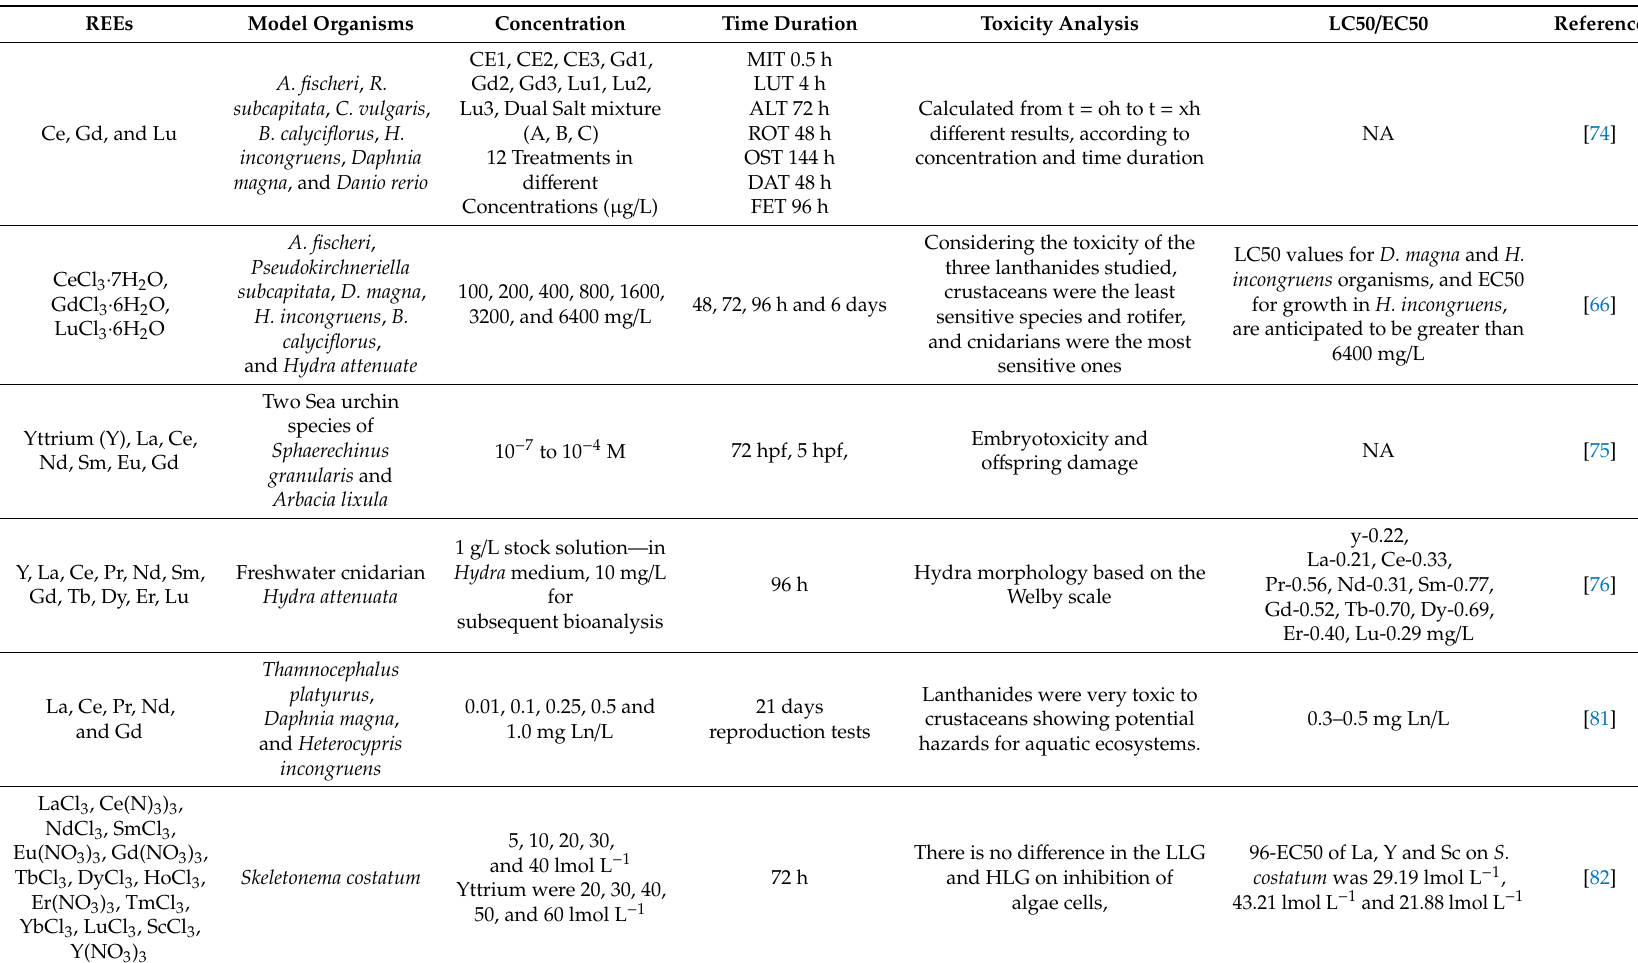
Table 2. Summary of the cumulative e ff ects of rare earth elements (REEs) on aquatic